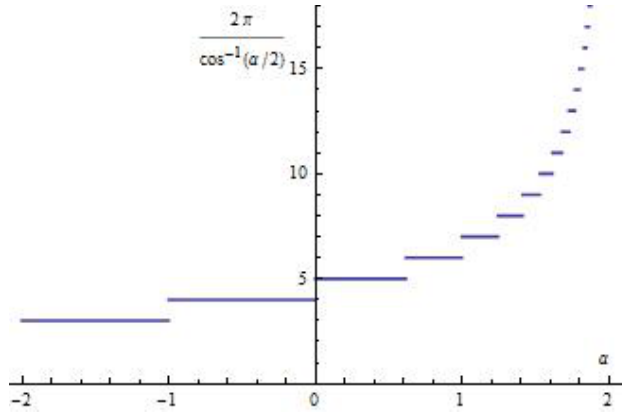
Figure 5. Minimal possible period (M.P.P.) as a function of parameter α .